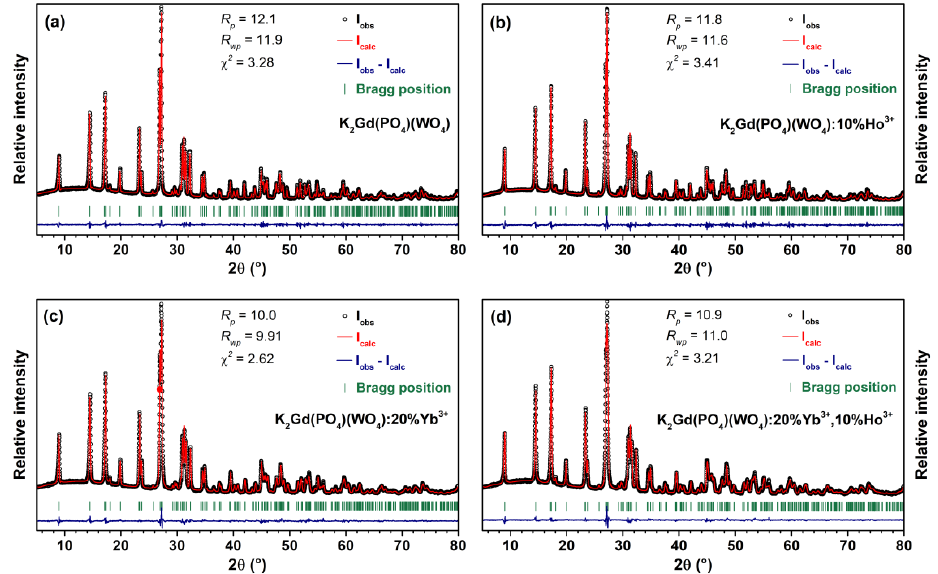
Figure 1. Rietveld refinement of undoped K 2 Gd(PO 4 )(WO 4 ) ( a ), K 2 Gd(PO 4 )(WO 4 ):10%Ho 3+ ( b ), K 2 Gd(PO 4 )(WO 4 ):20%Yb 3+ ( c ), and K 2 Gd(PO 4 )(WO 4 ):20%Yb 3+ ,10%Ho 3+ ( d ) XRD patterns.